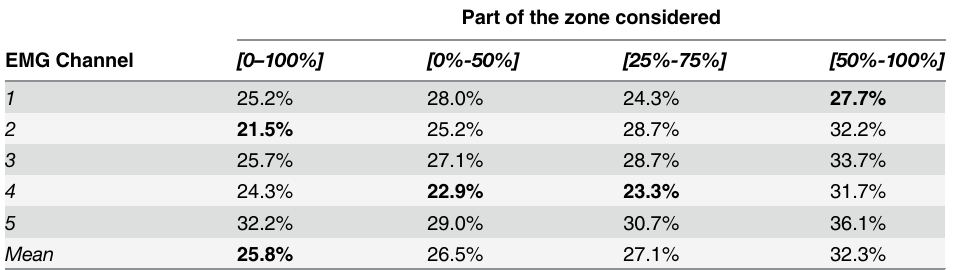
Each column of the table shows which part of the zone is being considered, where 0% represents the zone start and 100% the zone end (e.g. in 50%-100% interval only the samples in the last half of each zone are being